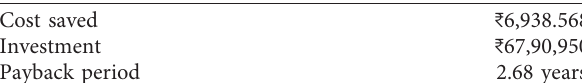
Table 11: Cost saving and payback